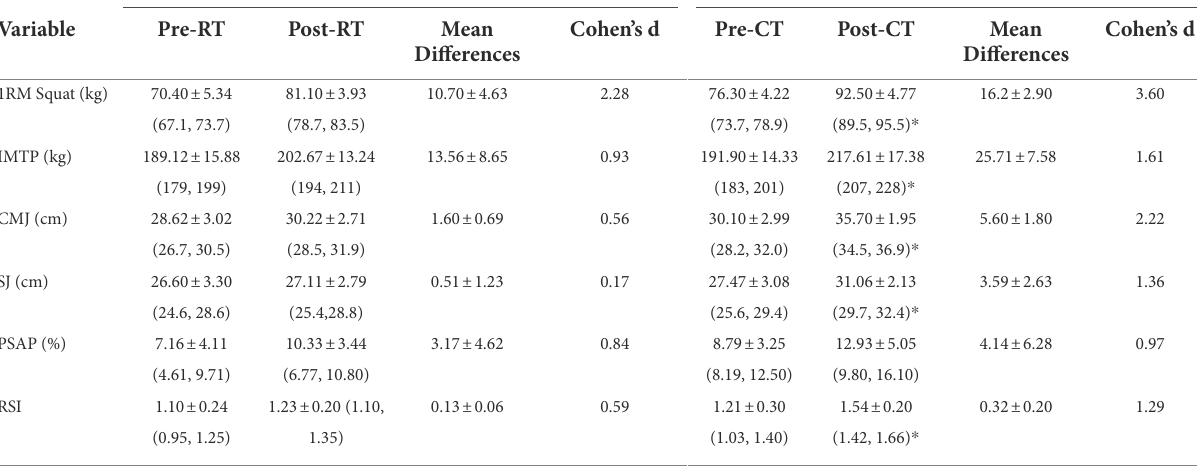
TABLE 3 The assessment results for week 1–8 (RT) and week 10–18 (CT). Week 1–8 (RT) mean difference with 95% of confidence